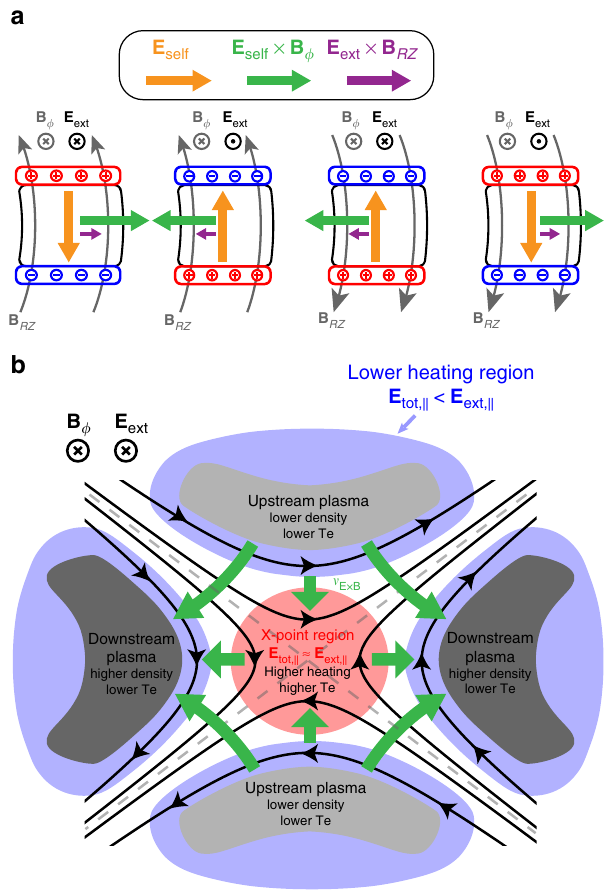
Fig. 9 Comprehensive plasma dynamics in the complex EM topology. a Topological relationships between the external EM fi elds, corresponding i (orange), self-induced mean space-charges, mean self-electric fi elds h E RZ self i ´ B ExB drift in the direction of h E RZ ϕ (green), and externally-driven ExB self ´ B drift in the direction of E ϕ RZ (purple) in various combinations of EM ext fi elds. b Topology analysis of the quadrupole EM structure regarding the X- point that determines overall structure and behaviors of the plasma evolution. The magnitude of the total parallel electric fi eld in the X-point region (red) is larger than that in the other regions (blue). The mean ExB drifts (green) corresponding to the quadrupole magnetic structure yield two in fl ows and two out fl ows around the X-point. The plasma density of the downstream region (dark gray) is higher than that of the upstream region (pale